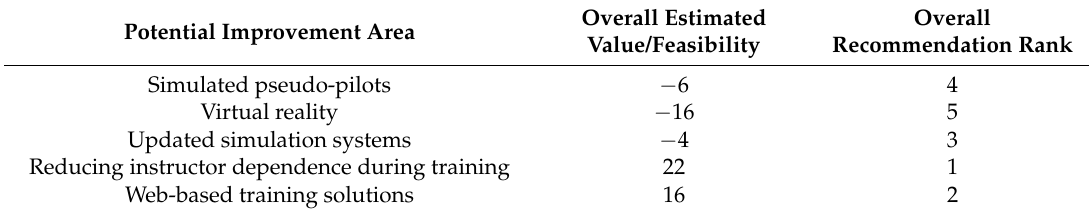
Table 1. Cost-benefit analysis